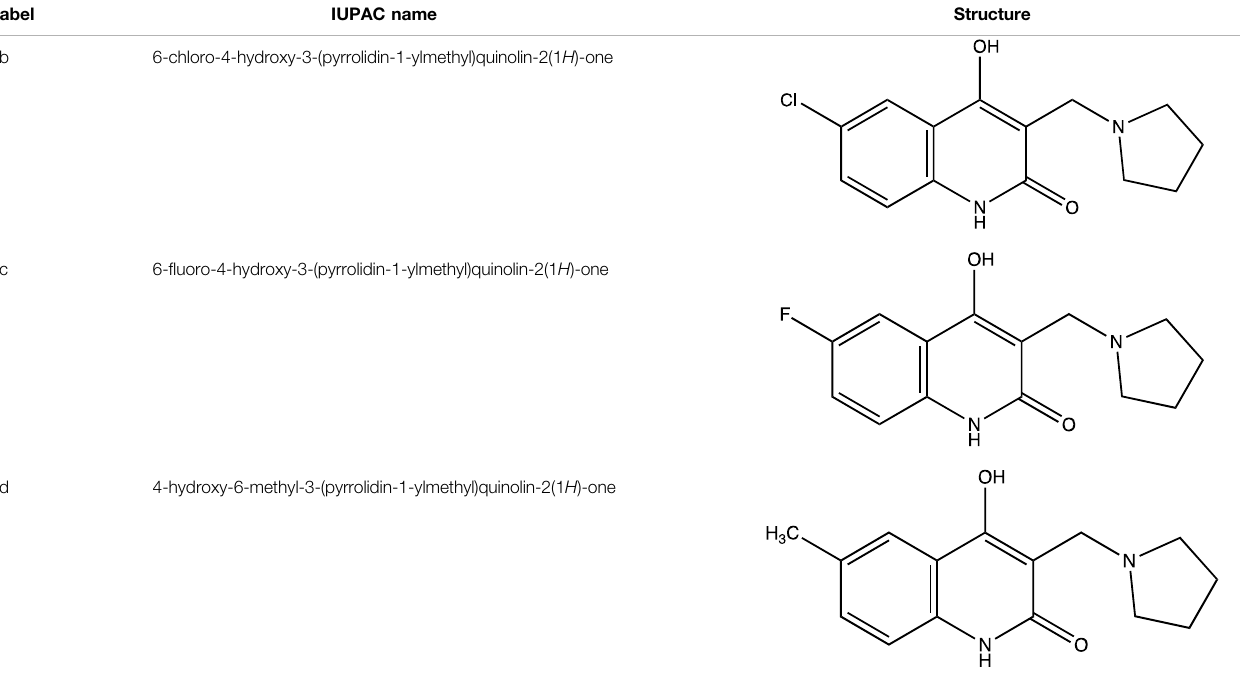
TABLE 1 | ( Continued ) Summary of the reagents, intermediates, synthesized compounds, their labels, IUPAC names and functional groups.